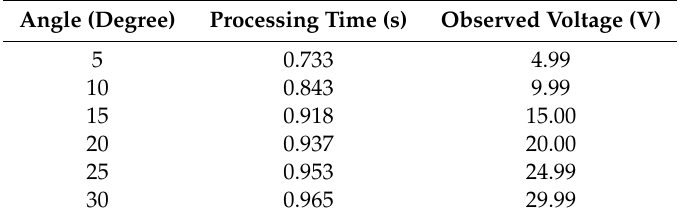
Table 1. Results of the beam-forming controls by the prototype system. Processing time is calculated by the logs of the captured image data and the remoted voltage meter in the experiments.